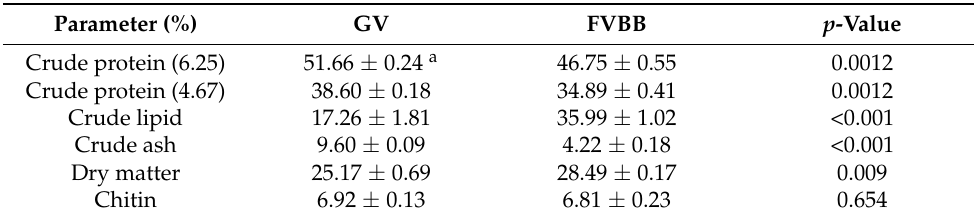
Table 3. Composition of BSFL biomass reared on the Gainesville (GV) and the fruit/vegetable/ bakery/brewery (FVBB) diets on dry matter basis.